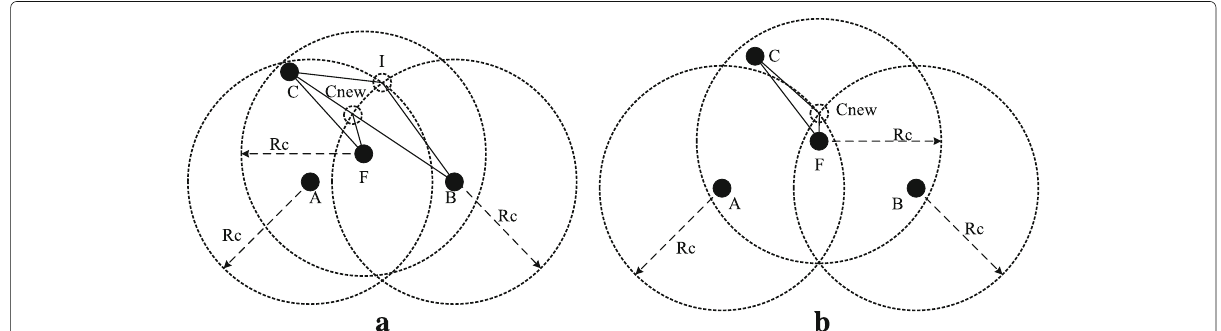
Fig. 4 Best position for relocating the backup node. a Node C is out of the communication range of A and B . b Node C is within the communication range of A and out of